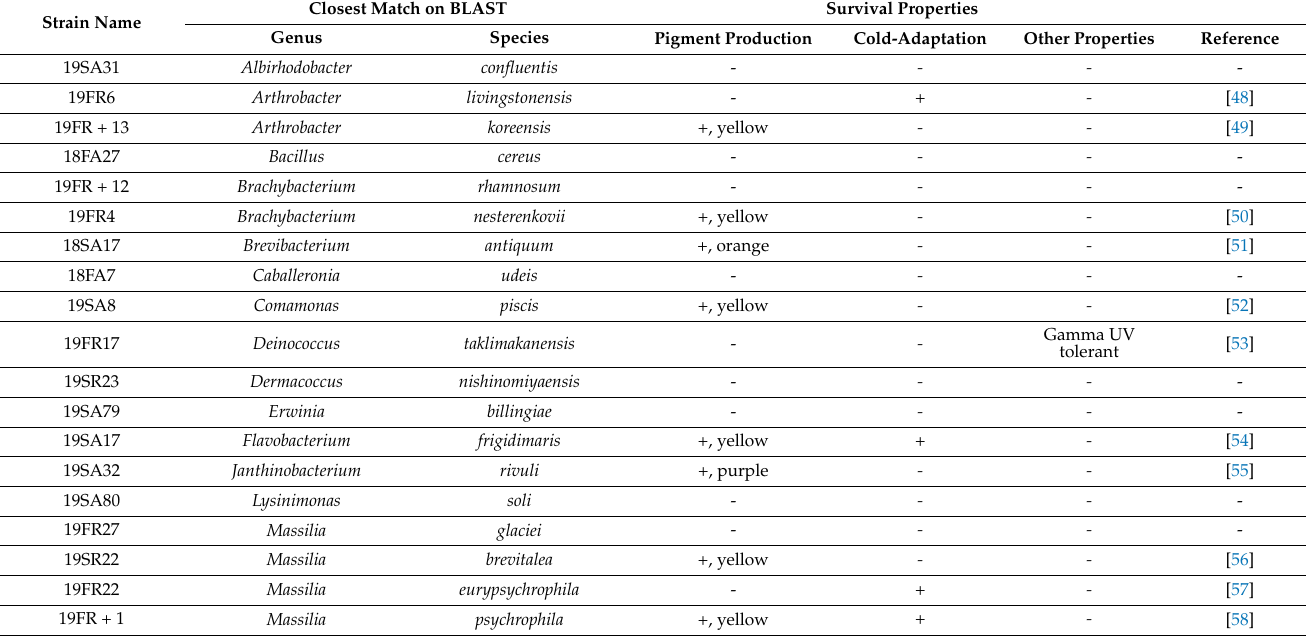
Table 2. Survival properties of the identified species based upon the literature. Yellow colour: possess survival properties. NCBI 16S ribosomal RNA sequences database was used on BLAST. * Previously isolated from